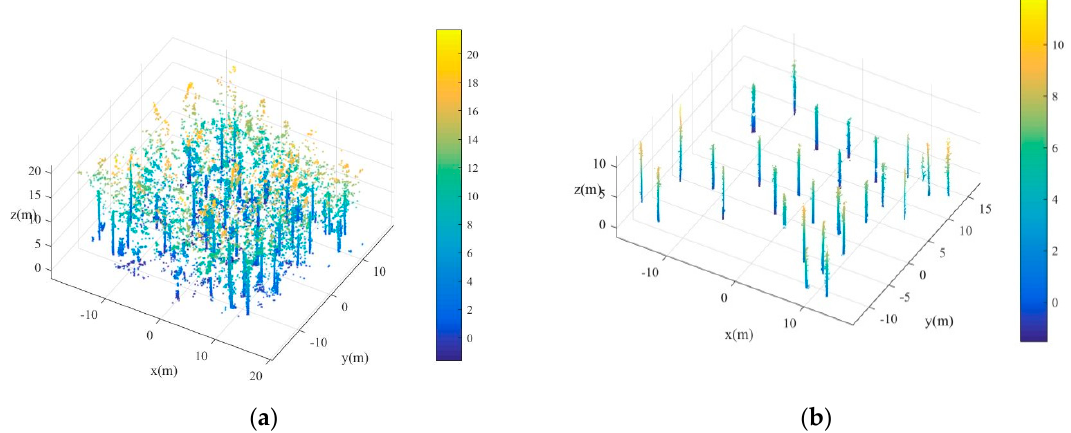
Figure 2. Trunk points extraction. ( a ) Trunk points extraction result using transductive transfer learning; ( b ) trunk points optimization after removing misjudged points.